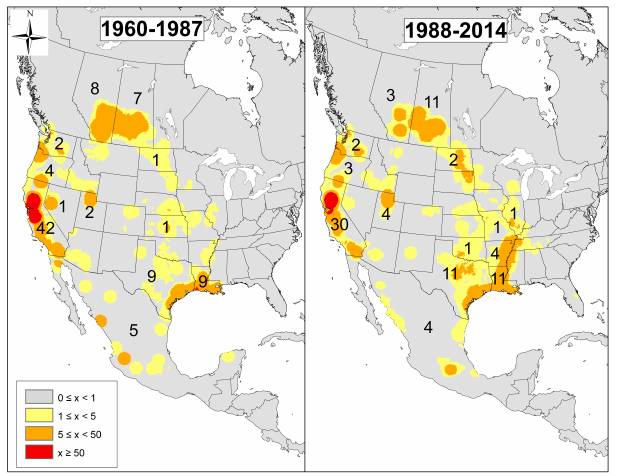
study into states along the Mississippi Alluvial Valley such as Louisiana, Arkansas, Mississippi, Missouri, Illinois, Tennessee, and Kentucky (Fig. 5). Other areas with notable increases in the proportion of total recoveries included Texas, Saskatchewan, North Dakota, and Utah. Similar to California, Alberta realized a notable decrease in recoveries over the study period. Fig. 5. Distribution of direct band recoveries of Northern Pintail ( Anas acuta ) banded in Alberta and Saskatchewan, Canada (≤ 54° N latitude) from 1960–1987 ( N = 3046) and 1988–2014 ( N = 2852). Colours represent the density of recovered bands/10,000 km². Numbers shown in Saskatchewan, Alberta, Mexico, and certain U.S. states are the percentage of the total recoveries for the time period; only regions with recoveries ≥ 1% are